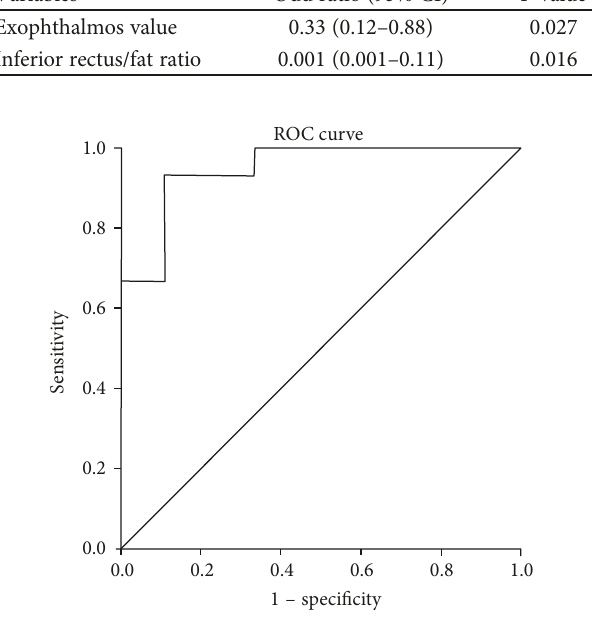
Figure 3: ROC analysis of the inferior rectus/fat ratio combined with the exophthalmos value to indicate response to GC in GO patients. (AUC =0.95; 95% CI: 0.88 – 1.00; sensitivity, 86.7%; speci fi city, 88.9%, P < 0 001 ). Cut-o ff point of the inferior rectus/ fat ratio: 1.42; cut-o ff point of the exophthalmos value: 20.78.